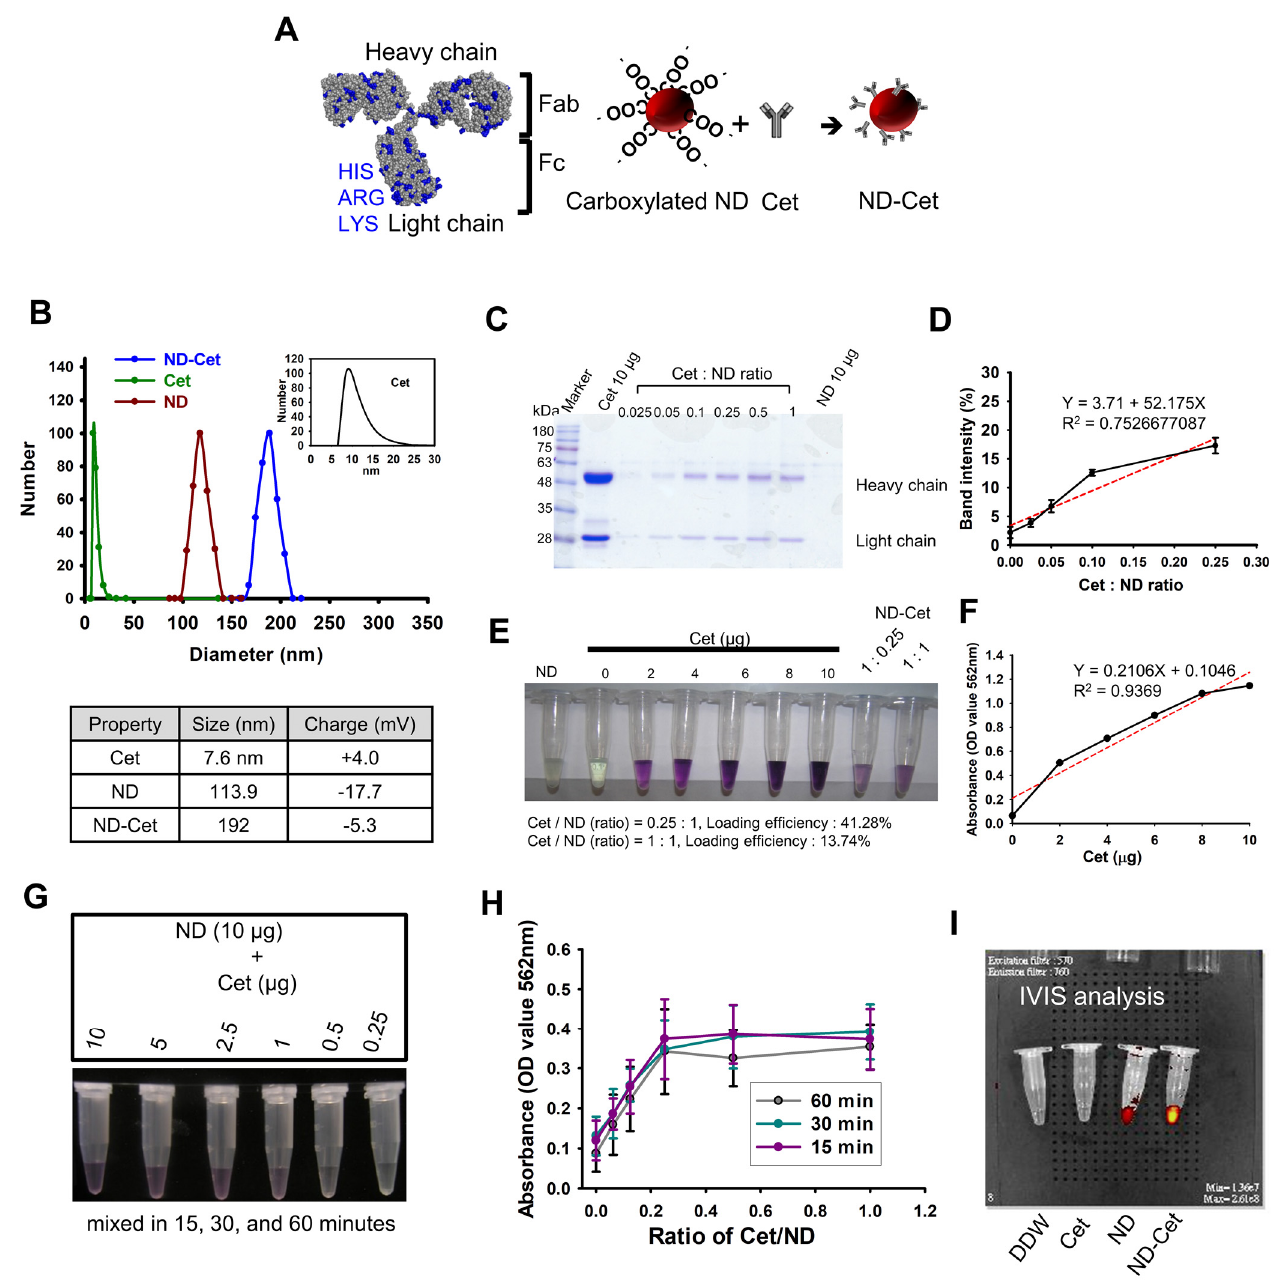
Figure 4. The characterization of the conjugation of ND and Cet. ( A ) The Cet structure shows by PyMOL software. The basic amino acid: arginine (ARG), lysine (LYS), and histidine (HIS) (shown in blue). PI of Cet: 8.44; pH < PI, the protein with positive charge. ( B ) The average size of Cet, ND, and ND-Cet were analyzed by DLS. The concentration of 1 µ g/mL of ND and ND-Cet in DDW was used for analysis. The zeta potential of Cet, ND, and ND-Cet were analyzed. The